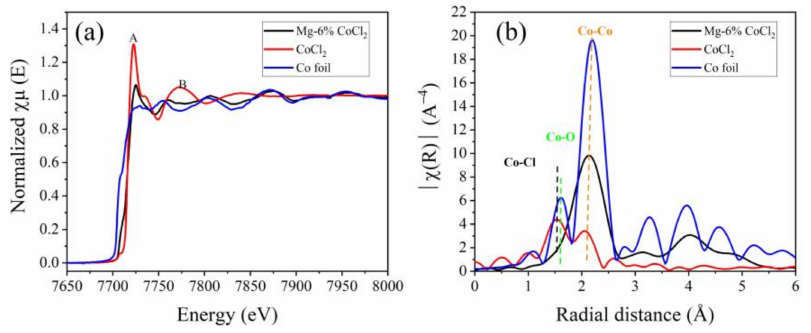
Figure 11. ( a ) Normalized XANES spectra at the Co K-edge, ( b ) Fourier-transformed extended X-ray absorption fine structure (EXAFS) of the Mg-CoCl 2 samples together with CoCl 2 and Co foil.